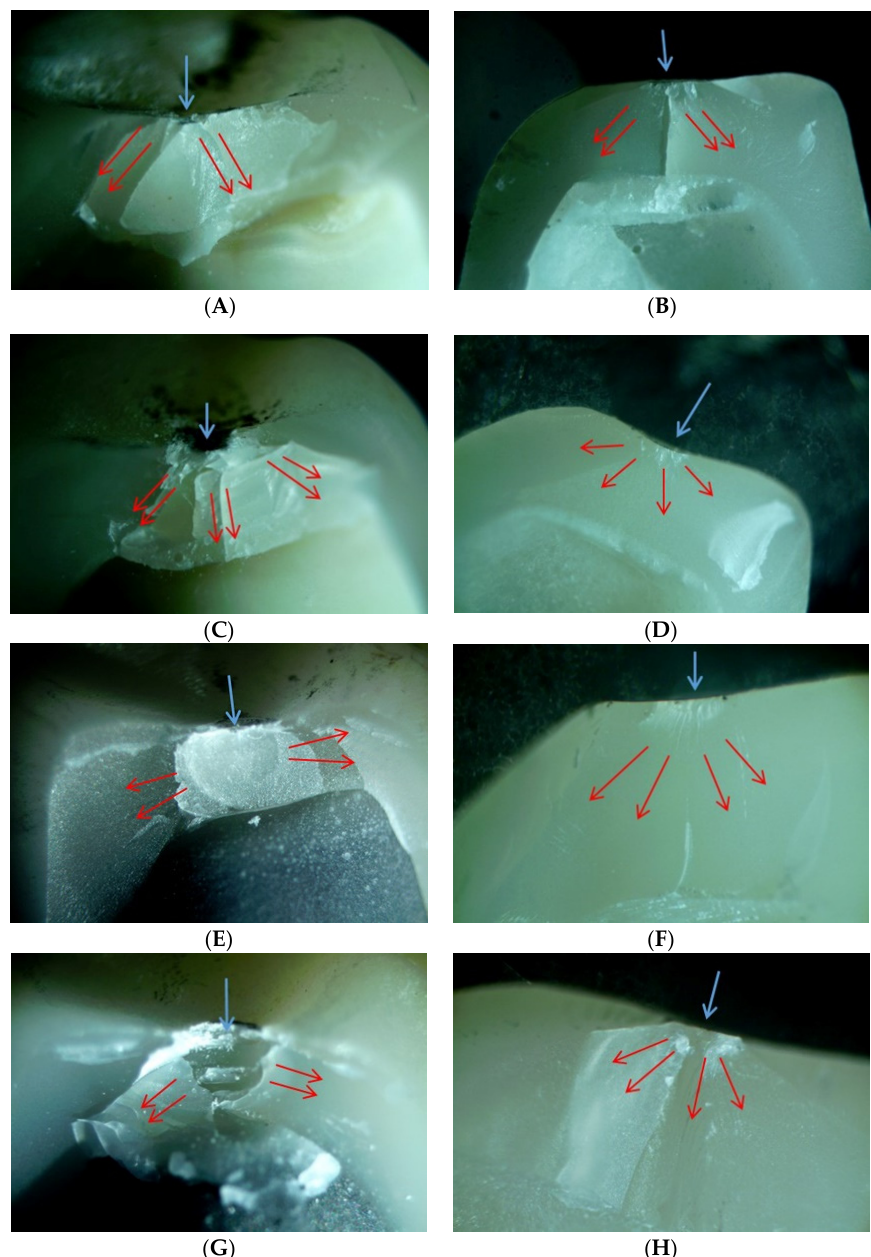
Figure 6. Stereomicroscopy images (25× magnification) of crowns corresponding to the load area ( A ): features of crown fracture of the representative crown from the PICN_TO group. ( B ): Features of crown fracture of the representative crown from the RNC_TO group. ( C ): Features of crown fracture of the representative crown from the ZLS_TO group. ( D ): Features of crown fracture of the representative crown from the LS_TO group. ( E ): Features of crown fracture of the representative crown from the PICN_TI group. ( F ) Features of crown fracture of the representative crown from the RNC_TI group. ( G ): Features of crown fracture of the representative crown from the ZLS_TI group. ( H ): Features of crown fracture of the representative crown from the LS_TI group. Blue arrows indicate the load areas; red arrows refer to the directions of the crack propagations. PICN, polymer-infiltrated-ceramic-network; TO, tooth abutment; RNC, resin nano ceramic; ZLS, zirconia-reinforced lithium silicate; LS, lithium disilicate; TI, titanium